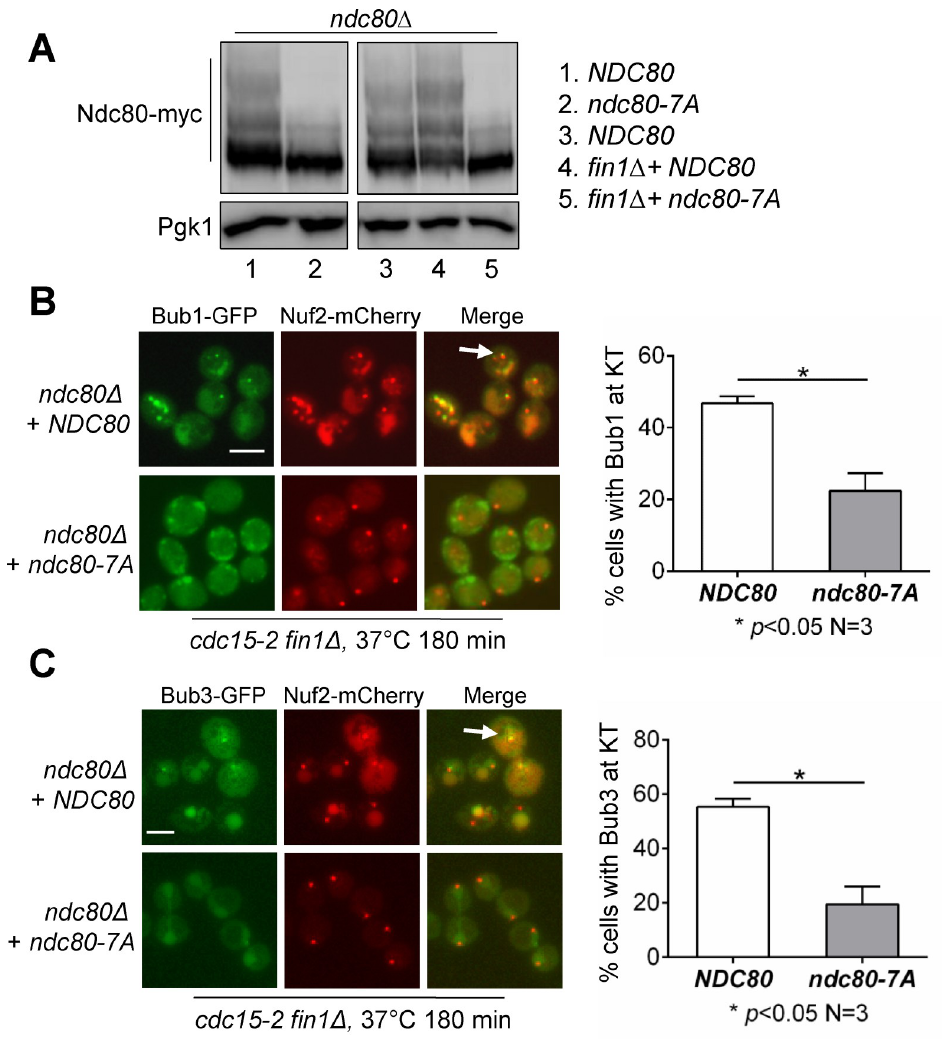
Fig 6. Ndc80 dephosphorylation promotes Bub1 dissociation from the kinetochore during anaphase. (A) Reduced phosphorylation for phospho-deficient Ndc80-7A proteins. fin1 Δ ndc80 Δ cells carrying WT NDC80-myc (3893-10-3) and phospho-deficient ndc80-7A-myc (3897-5-3) plasmids were grown to log phase at 30˚C. Protein samples were prepared from asynchronous cells and run on Phos-tag gel. Western blot was probed with anti-myc antibody to show separation of phosphorylated species. (B) Bub1 kinetochore localization in ndc80-7A cells during anaphase. fin1 Δ ndc80 Δ cdc15-2 BUB1-GFP NUF2-mCherry cells carrying either NDC80 (3975-5-3) or ndc80-7A (3941-1-4) plasmids were grown to log phase in YPD at 30˚C then shifted to the non-permissive temperature of 37˚ for 180 minutes to inactivate Cdc15. Samples were collected and pictures taken. Anaphase cells with Bub1-kinetochore co-localization was counted (n = 100). White arrows indicate co-localization. The experiment was repeated three times and statistical significance determined by p < 0.05 using Wilcoxon rank sum test. Scale bar, 5 μ m. (C) Bub3 kinetochore localization in ndc80-7A cells during anaphase. The same protocol was used to examine kinetochore localization of Bub3 (3893-9-2 and 4057-26-1). The experiment was repeated three times and statistical significance determined by p < 0.05 using Wilcoxon rank sum test. Scale bar, 5 μ m. results suggest that Ndc80 dephosphorylation causes viability loss when syntelic chromosome attachment occurs. We speculate that decreased kinetochore binding of Bub1-Bub3 in ndc80- 7A cells results in premature SAC silencing and/or increased erroneous kinetochore attach- ments, leading to viability loss when syntelic attachment is induced.